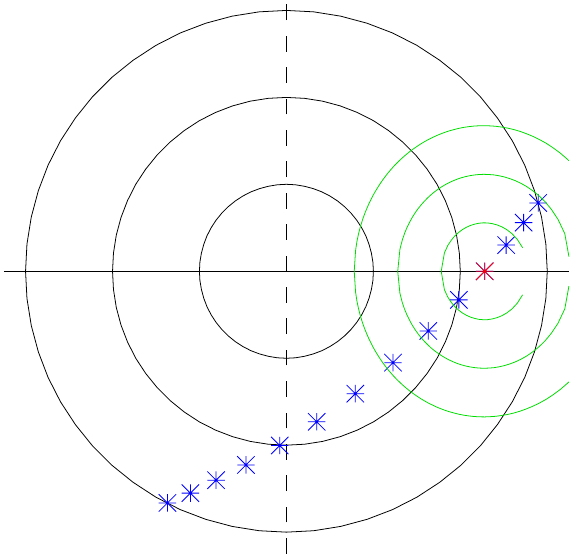
Fig. 1. Typical geometry by PARASOL multidirectional observa- tions for a pixel that is observed in the backscatter direction. The black circles show the view angle by steps of 20 ◦ , the straight plain line shows the principal plane and the dashed line shows the perpen- dicular plane. The green ellipses show the scattering angles by steps of 10 ◦ . Each symbols indicates the viewing geometry of one of the 14 successive observations. The red symbol shows the observation acquired in the near-backscatter direction.